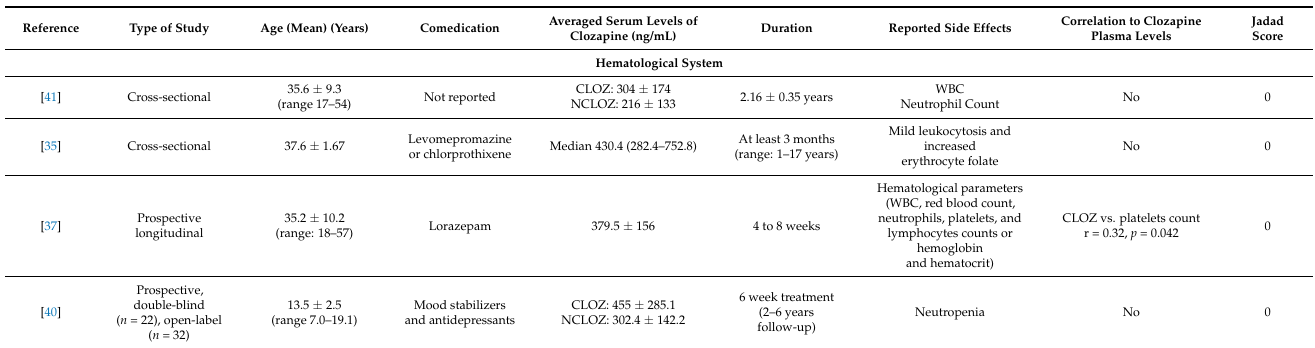
Table 7. Studies reporting hematological, genitourinary, and other adverse effects in relation to CLOZAPINE blood